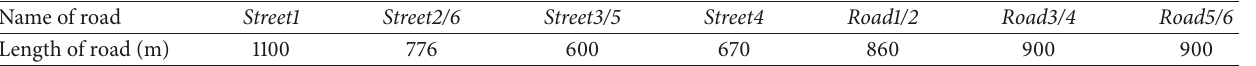
Table 3: Length of road setting.